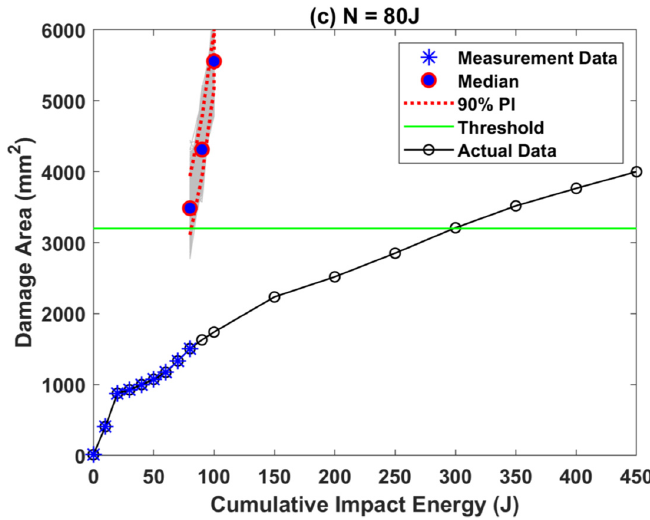
Figure 7. The prediction results for Delamination Dataset 2 using the Paris model with failure threshold assumed to be at 1200 mm 2 . The grey lines represent the particle trajectories for 1000 particles.